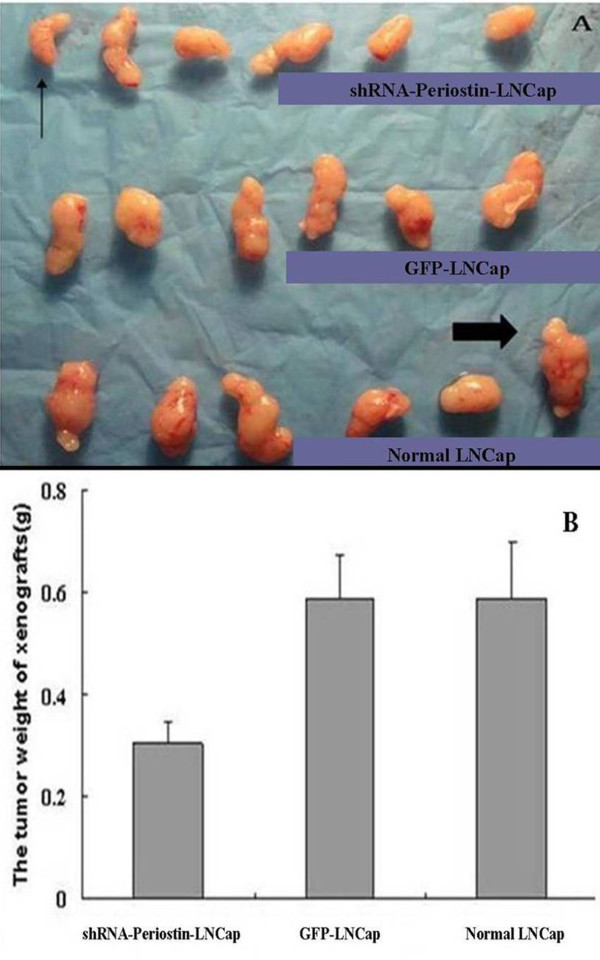
The burden of the xenografts. A:The tumors of the xenografts were listed, micr-arrow represented the minimum tumor and pykno-arrow represented the maximum tumor. B: The mean burden of tumors was minimum in the group of LNCap cells with down-regulated Periostin(P <0.05).